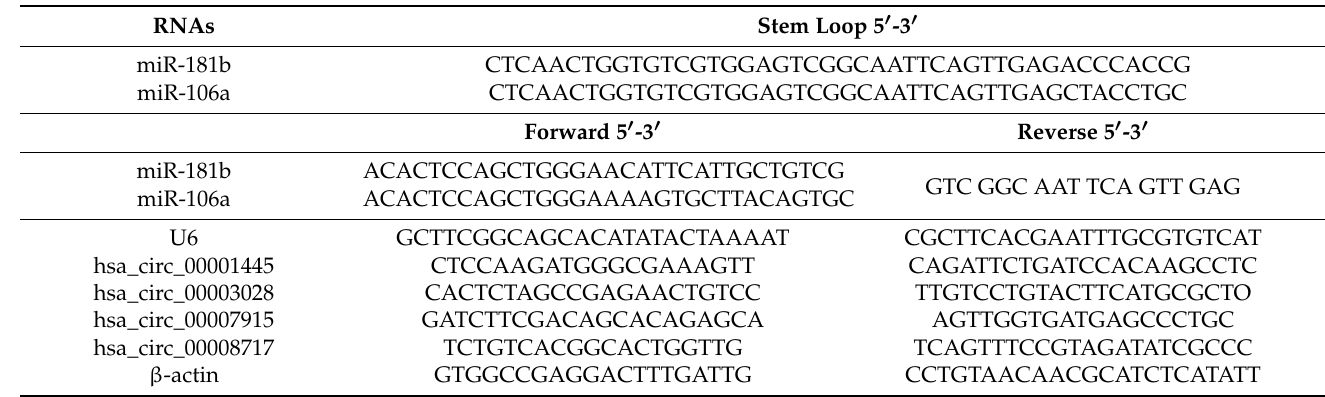
Table 4. Primer sequences (Sigma Aldrich, Taufkirhen, Germany) of analyzed circRNAs, miRNAs and respective endoge- nous controls.